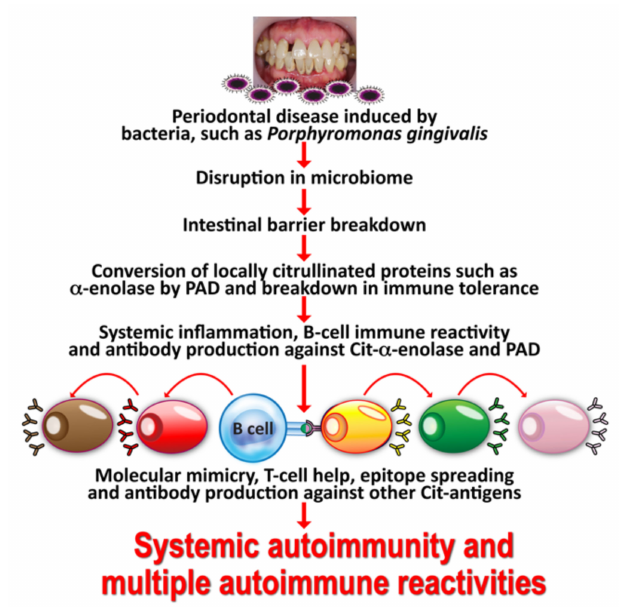
Figure 2. Mechanism by which oral infection can lead to multiple autoimmune reactivities. Oral infectious agents reach the gut and disturb the gut flora, leading to a disrupted epithelium and gut permeability. Local inflammation generates autoantigens by PAD; antibody production starts against one autoantigen, but through epitope spreading reaches out to multiple antigens, leading to systemic inflammation, multiple autoimmune reactivities, and systemic